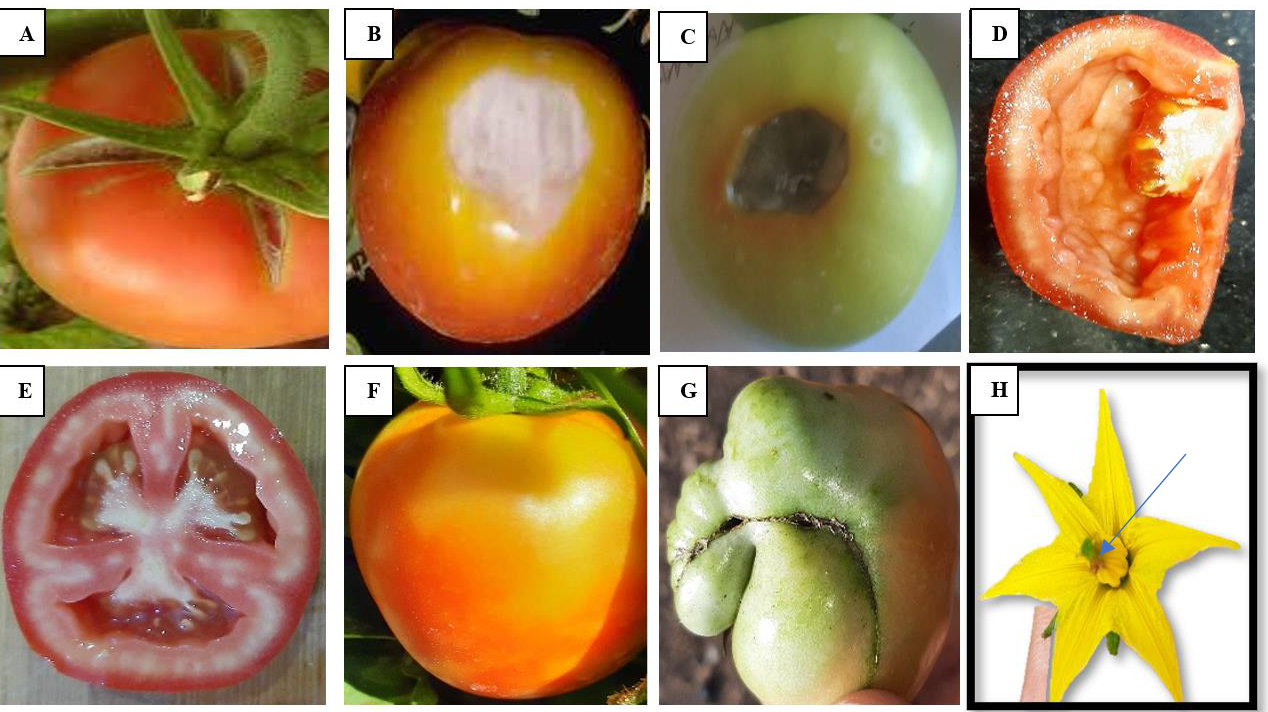
Figure 9. Common physiological diseases during the experiment (( A ) cracking, ( B ) sunscald, ( C ) blossom-end rot, ( D ) puffiness, ( E ) white internal tissue, ( F ) blotchy ripping, ( G ) cat face and ( H ) exserted stigma).